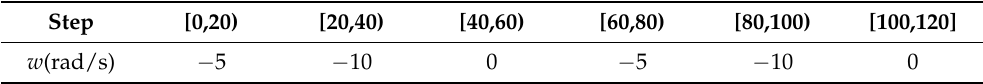
Table 4. Maneuvering process in